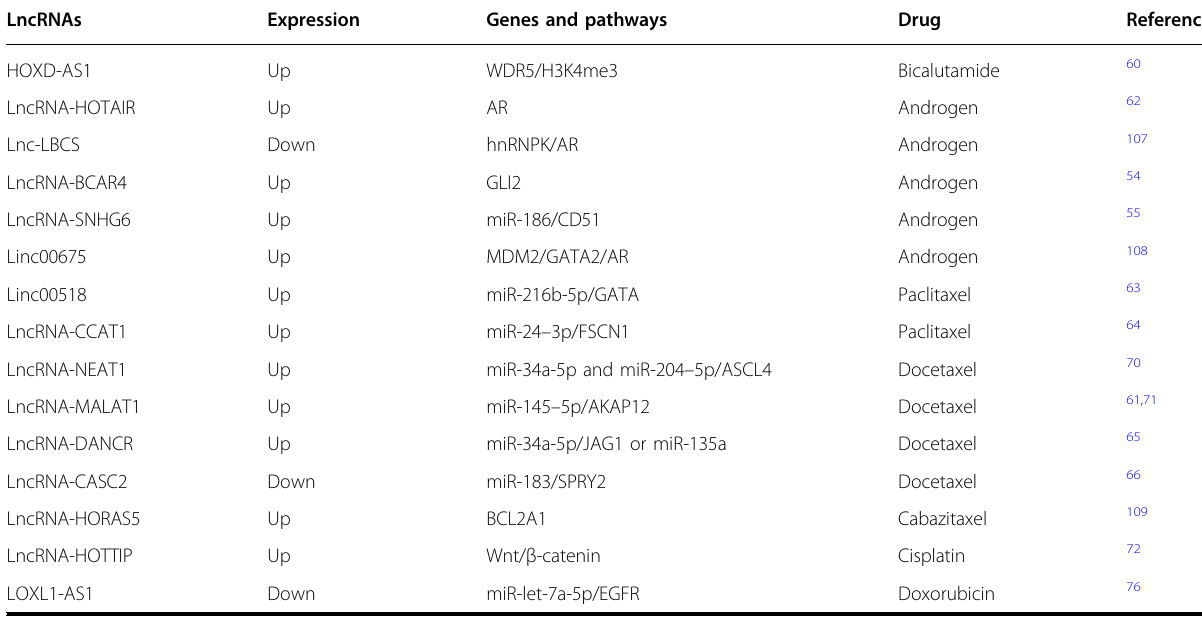
Table 4 LncRNA and drug resistance in prostate cancer.